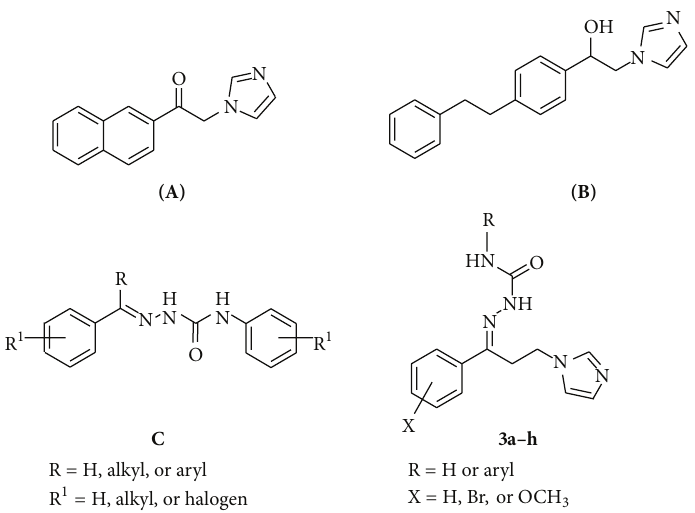
Figure 1: Chemical structures of nafimidone (A) , denzimol (B) , arylsemicarbazones C , and the test compounds 3a – h .